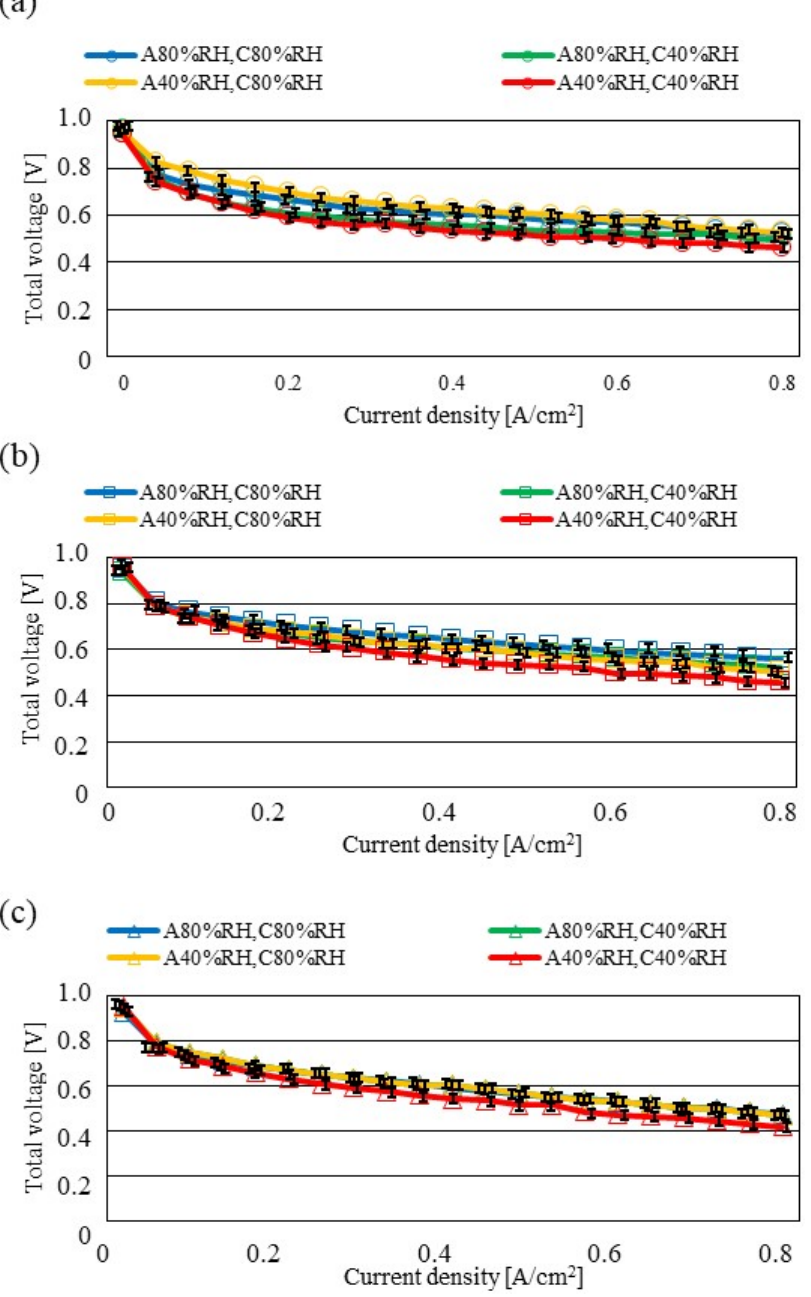
Figure 4. Comparison of polarization curves among different RHs for a separator thickness of 2.0 mm: ( a ) T init = 353 K; ( b ) T init = 363 K; ( c ) T init = 373 K A80%RH&C80%RH, A80%RH&C40%RH, A40%RH&C80%RH and A40%RH&C40%RH were